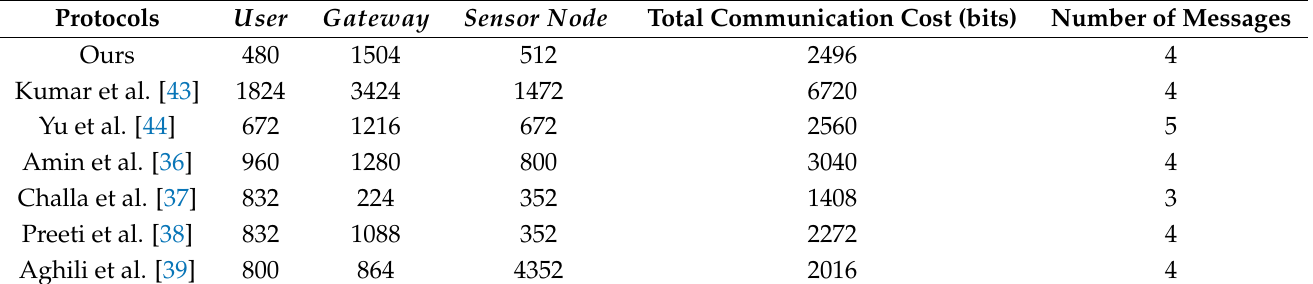
Table 7. Comparison of